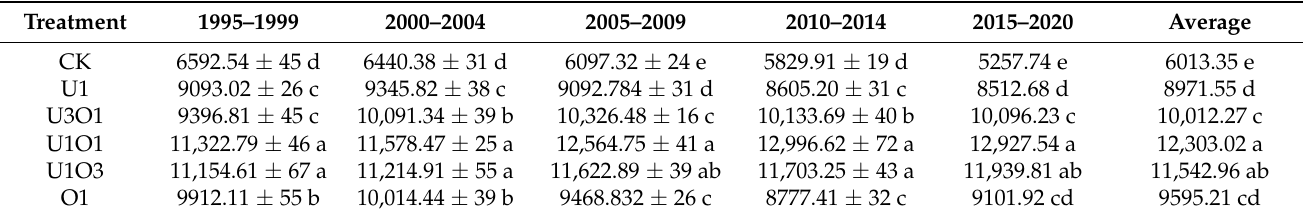
Table 7. DNDC model of the multi-year average maize grain yield (kg ha − 1 ) under different fertiliza- tion